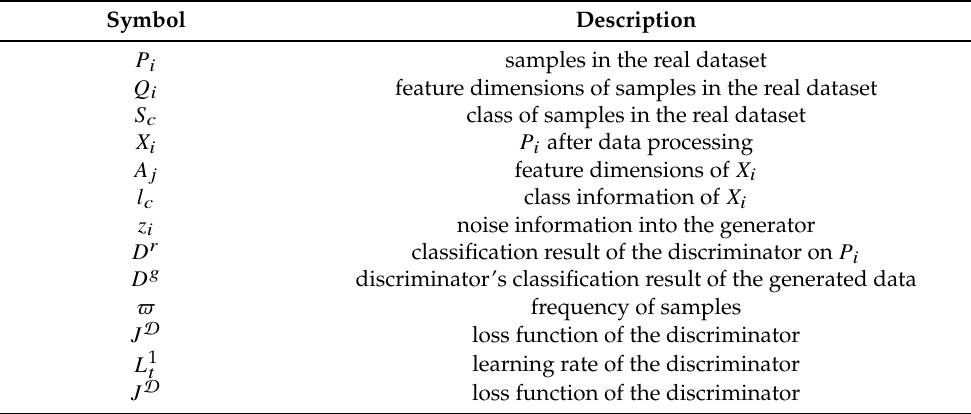
Table 1. Symbols used in this section and their interpretation.